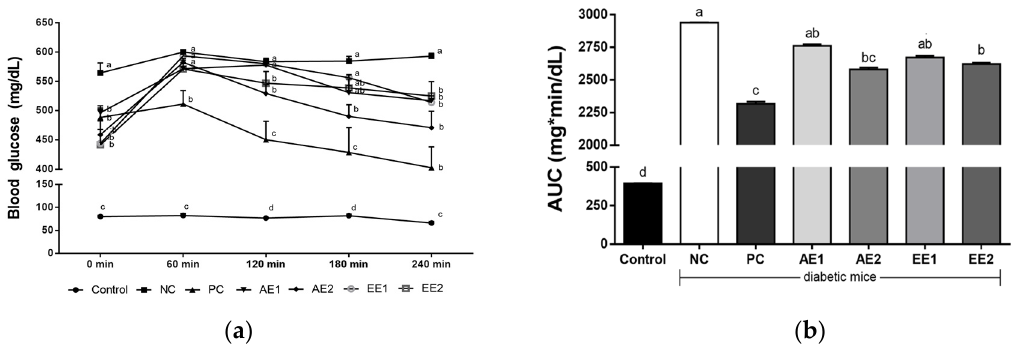
Figure 3. Effects of A. hookeri extracts on the OGTT of the diabetic mice. ( a ) Blood glucose changes, ( b ) area under the curve (AUC). Control: non-diabetic mice; NC: negative control; PC: positive control, metformin 150 mg/kg BW; AE1: aqueous extract 100 mg/kg BW; AE2: aqueous extract 200 mg/kg BW; EE1: ethanol extract 100 mg/kg BW; EE2: ethanol extract 200 mg/kg BW. AE and EE groups were treated with A. hookeri extracts for 8 weeks. Data are presented as the mean ± SEM (n = 8). a–d Mean values with different letters are significantly different at p < 0.05.